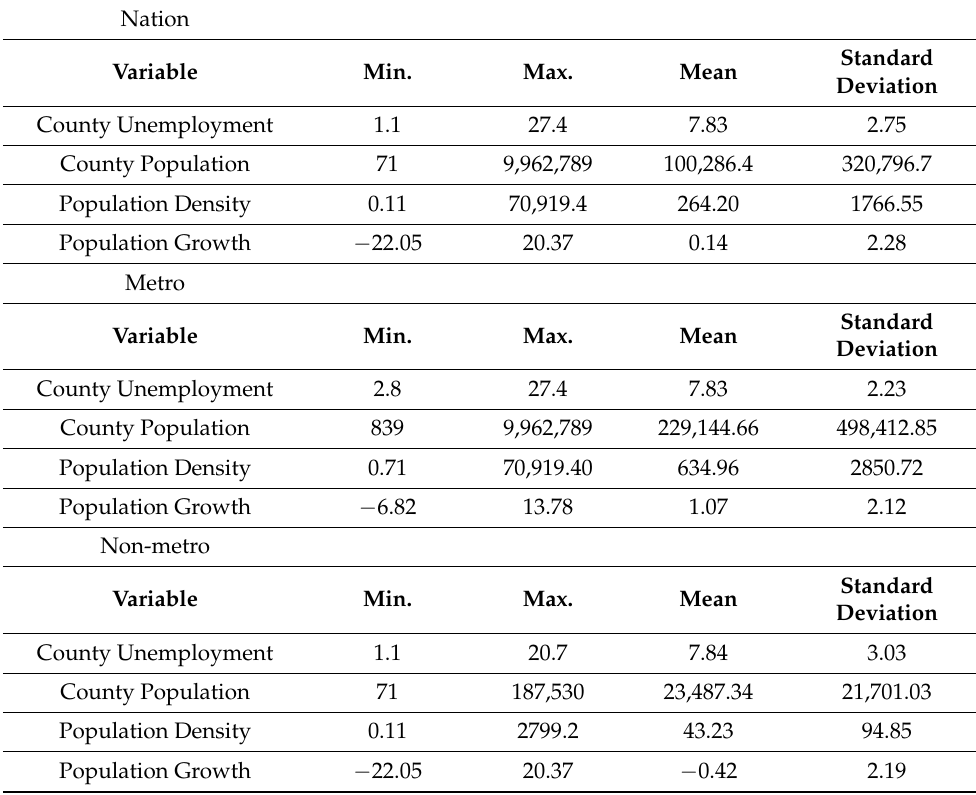
Table A7. Descriptive statistics for county’s general characteristics.